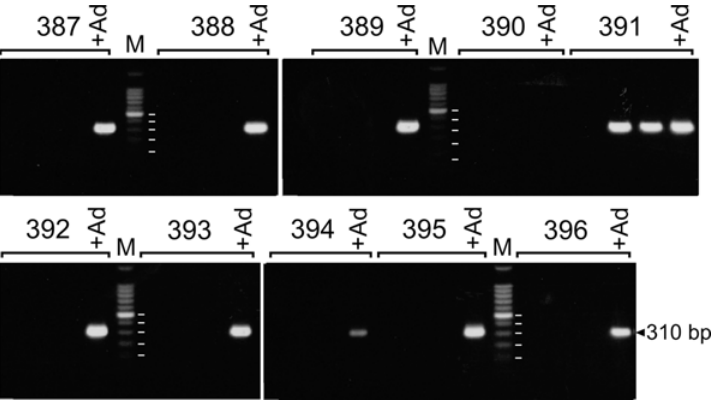
Fig 1. Detection of adenoviral DNA in umbilical vein cord blood. Lymphocytes enriched by Ficoll density gradient centrifugation were evaluated for adenoviral DNA by a nested PCR assay targeting a conserved region of the hexon gene. Four replicates of each numbered cord blood sample were analyzed. As a positive control, five copies of the type 2 adenovirus genome were added to the fourth replicate (+Ad). Lanes indicated by ‘ M ’ contained a 100-bp ladder reference. The position of DNA standards corresponding to 500, 400, 300, 200, and 100 bp were determined from a brighter exposure and are indicated. Cord blood samples 390 and 391 represent a negative and positive sample, respectively. These samples were reevaluated because of the failure of the positive control (390) and because the diagnostic 310 bp PCR product was observed in only two of three test samples (391). Samples were considered evaluable if the positive control amplified. Samples were considered to contain adenoviral DNA if the appropriate PCR product was observed in at least five of six technical replicates. All positive samples were evaluated on at least two